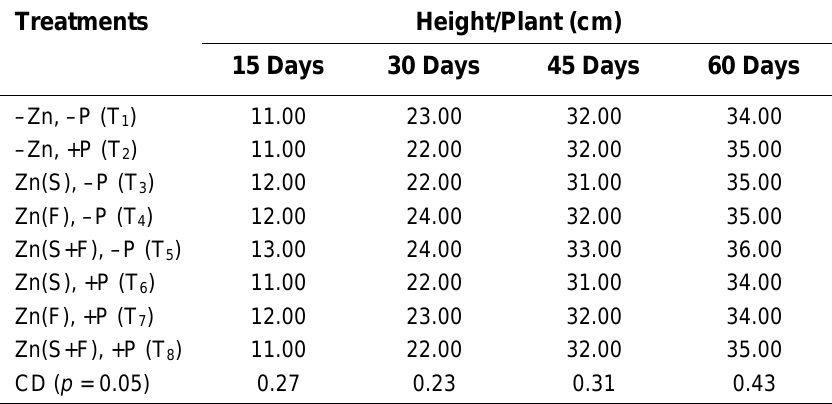
Interaction Effect Between Zn and P on the Height of Plant (cm) of Stevia ( S. rebaudiana ) (Mean of Four Replications) Height/Plant (cm) Treatments